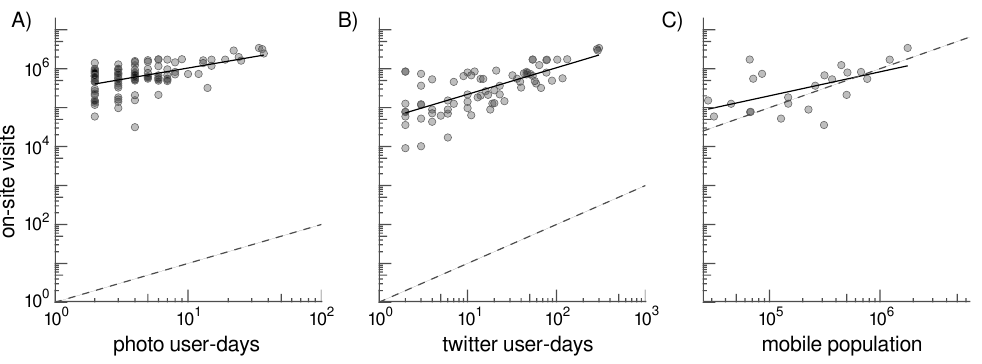
Figure 3. Relationships between three di ff erent user-generated measures of annual visitation—( A ) photographs (PUD), ( B ) tweets (TUD), and ( C ) mobile-phone communications (MP)—and on-site counts taken at 36 tourist sites. Dashed line represents a 1:1 relationship. Black lines show the best fit using ordinary least